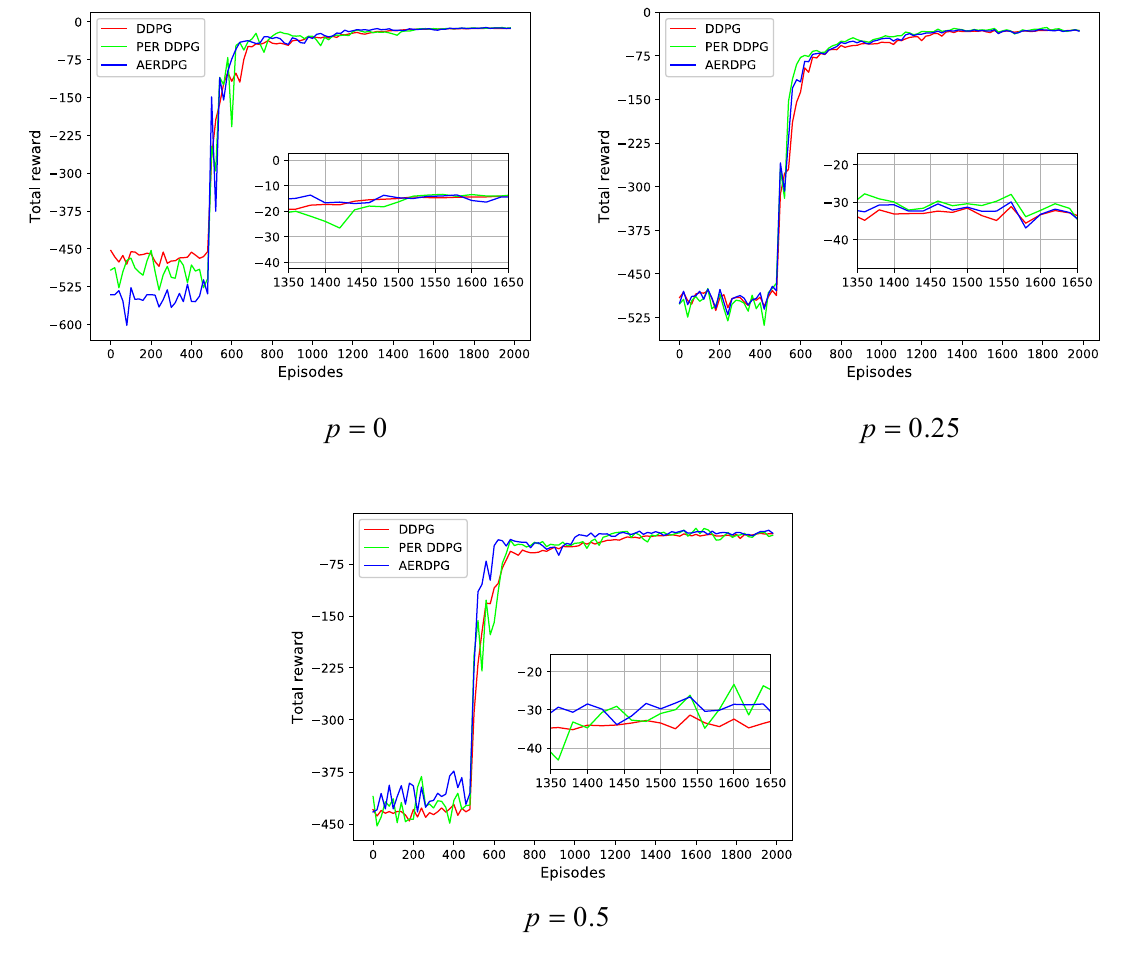
Figure 6. The total reward values.